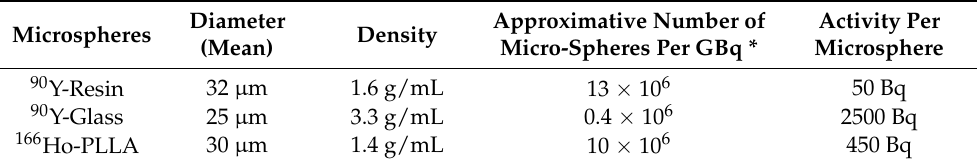
Table 2. Physical characteristics of radioactive